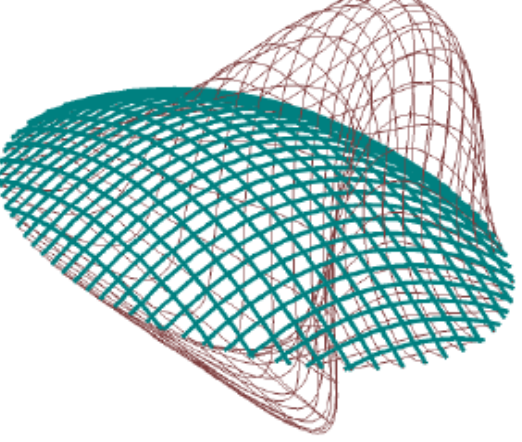
Figure 4. Exaggerated deflected shape under combined snow and wind loading.